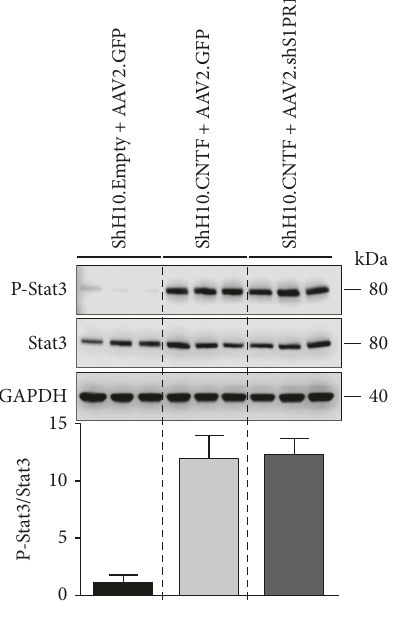
Figure 5: The expression of P-Stat3 is not changed by S1PR1 silencing after CNTF stimulation. The expression of P-Stat3 was assessed by western blotting in protein lysates (20 μ g) from retinae treated with ShH10 and AAV2 viruses. P-Stat3 and Stat3 blots were quanti fi ed by densitometry using the ImageJ software (NIH). The level of P-Stat3/Stat3 was not signi fi cantly di ff erent between mice treated with ShH10.CNTF/AAV2.shRNA-S1PR1 and ShH10.CNTF/AAV2.GFP. Three mice were analyzed for each